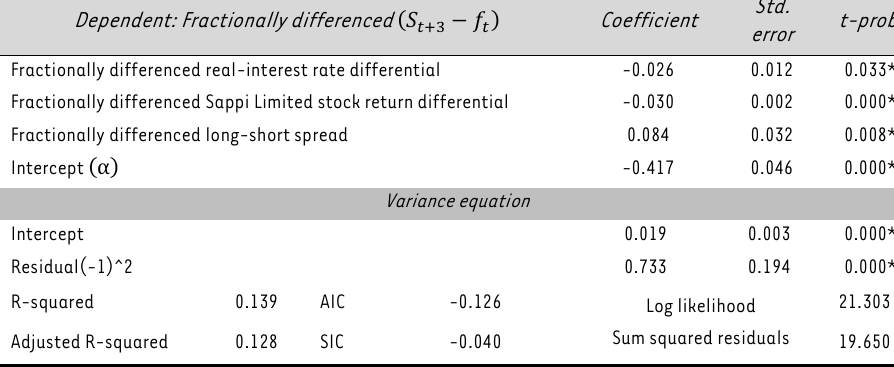
Constant parameter